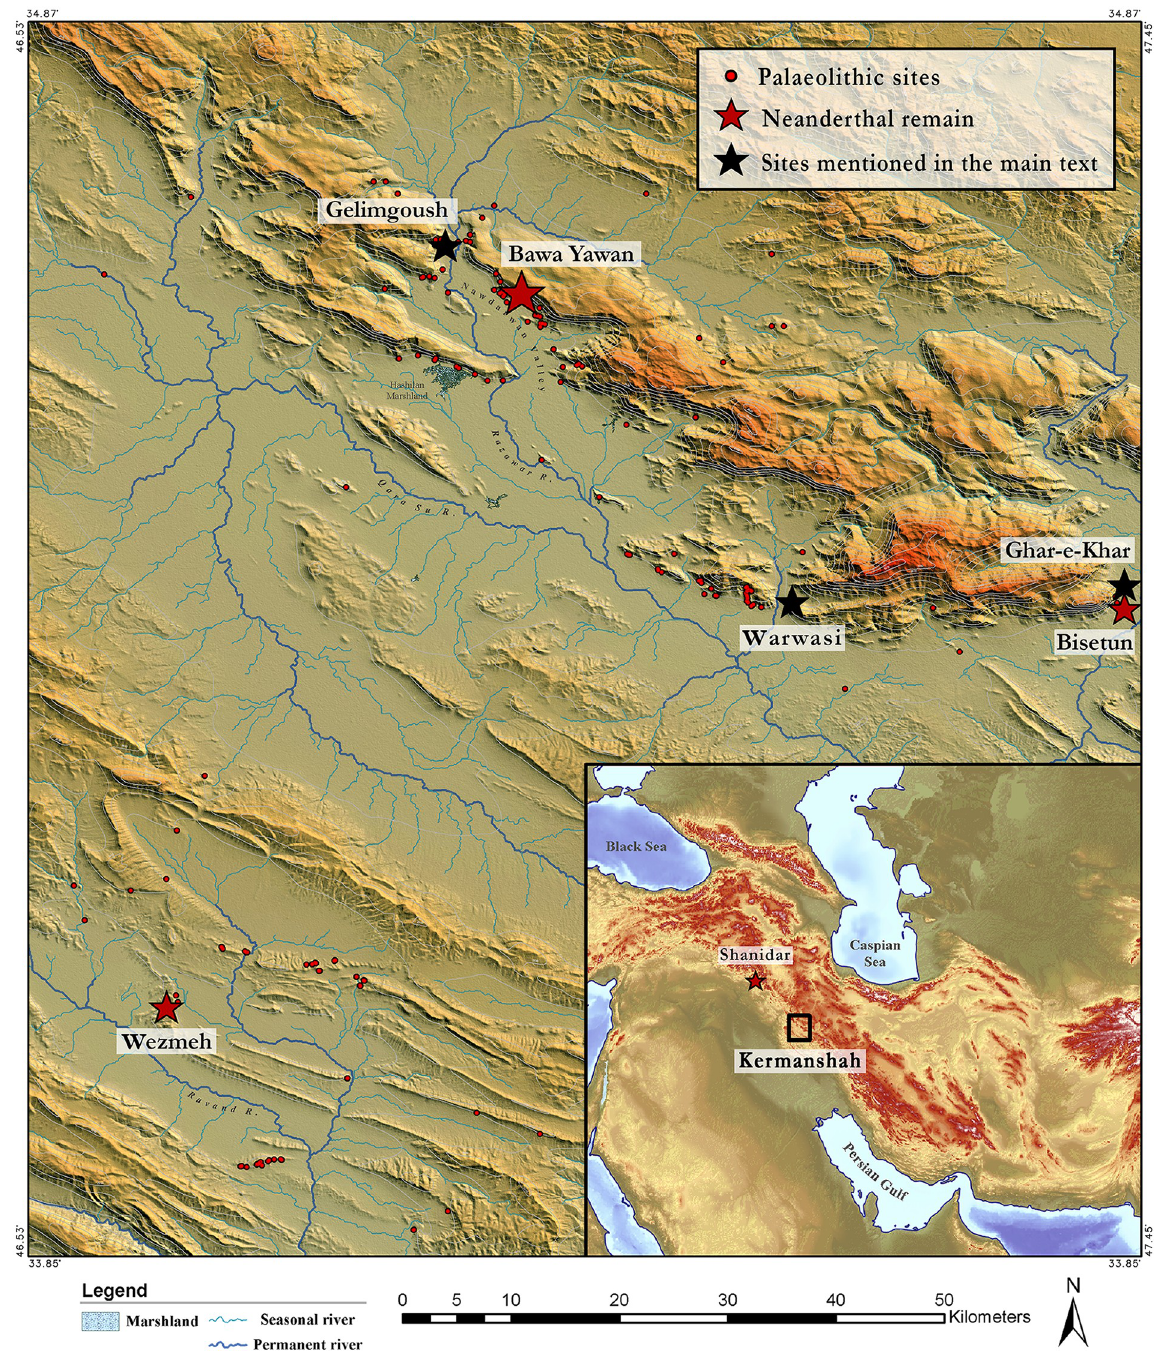
Fig 1. The inset map shows the location of the Kermanshah region in the Zagros Mountain. The main map shows the topography and hydrography of the Kermanshah region, the Bawa Yawan rockshelter in the Nawdarwan valley and the important sites mentioned in the